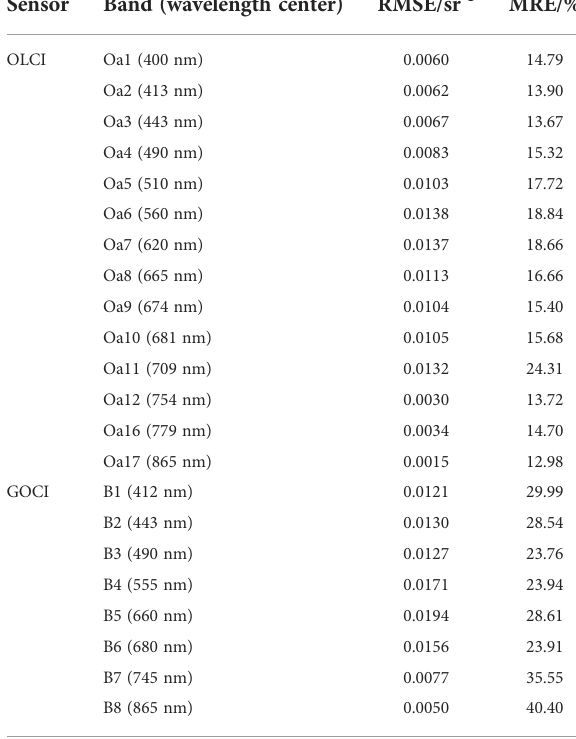
TABLE 2 Band-by-band RMSE and MRE statistics of the atmospheric correction results based on the OLCI and GOCI data. Sensor Band (wavelength